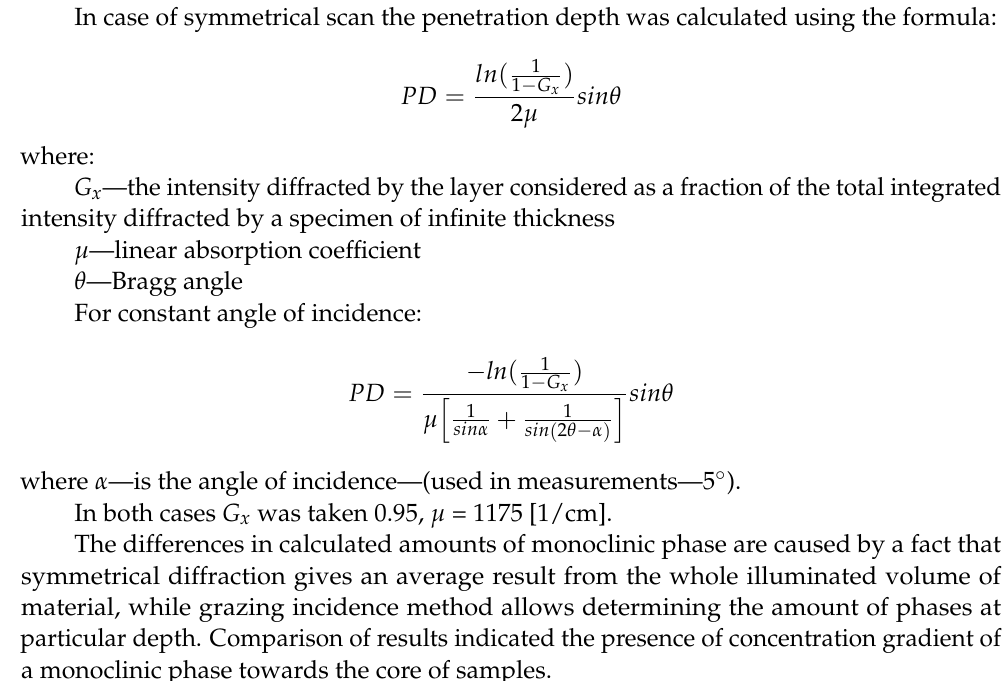
Figure 9. Penetration depth plot for symmetrical diffraction.